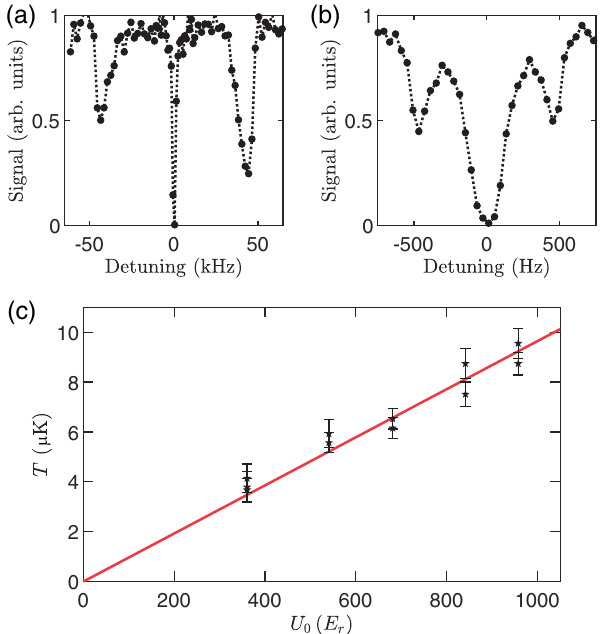
FIG. 6. Exemplary spectra of molecular (a) axial and (b) radial sidebands excited using Raman clock transitions, from which the motional frequencies are extracted to calibrate the lattice trap. (c) Measurement of the molecular temperature as a function of the trap depth (black stars) using Raman carrier thermometry. Error bars denote 1 σ uncertainties. A linear fit (solid red line) with the intercept fixed at the origin describes the data well ( χ 2